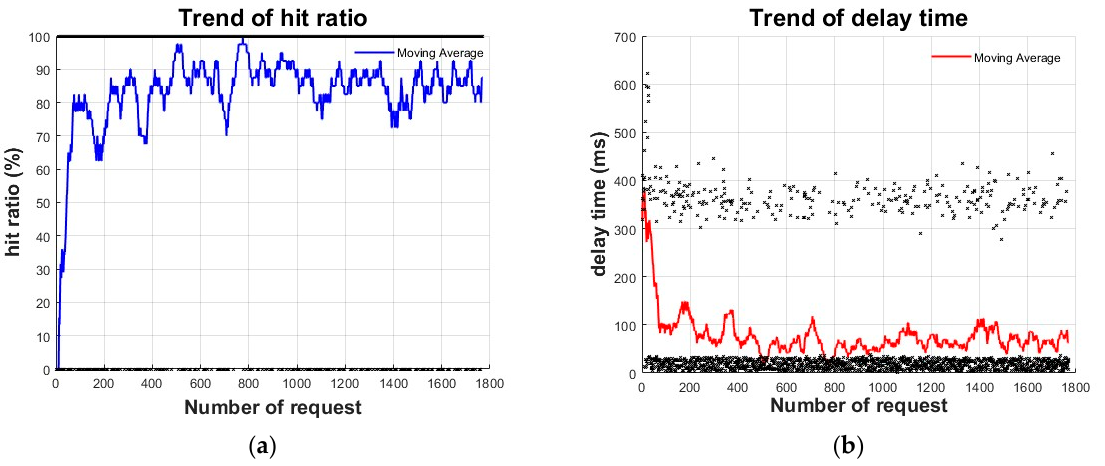
Figure 10. Content request results in the chronological order of the proposed method : ( a ) hit ratio; ( b ) latency.